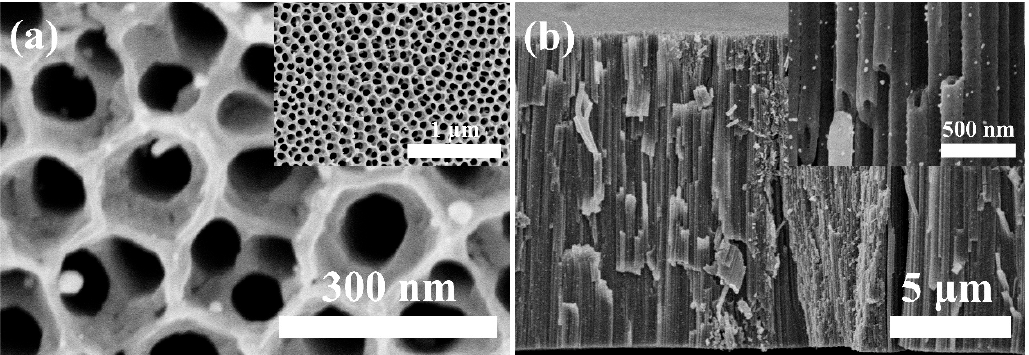
Figure 3. SEM images of TiO 2 NT@Au NP composite with 60 min growth time of TiO 2 nanotube. ( a ) Top view and ( b ) cross-section view SEM images of the TiO 2 NT (60 min)@Au NP composite.